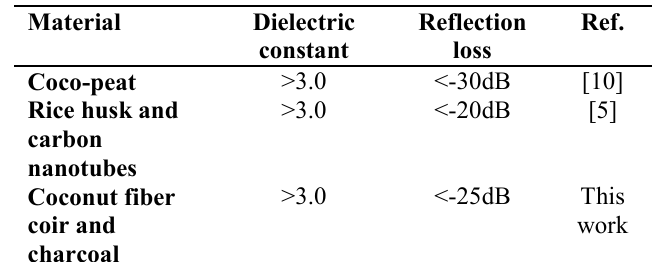
Table 3: Average dielectric constant and reflection loss of